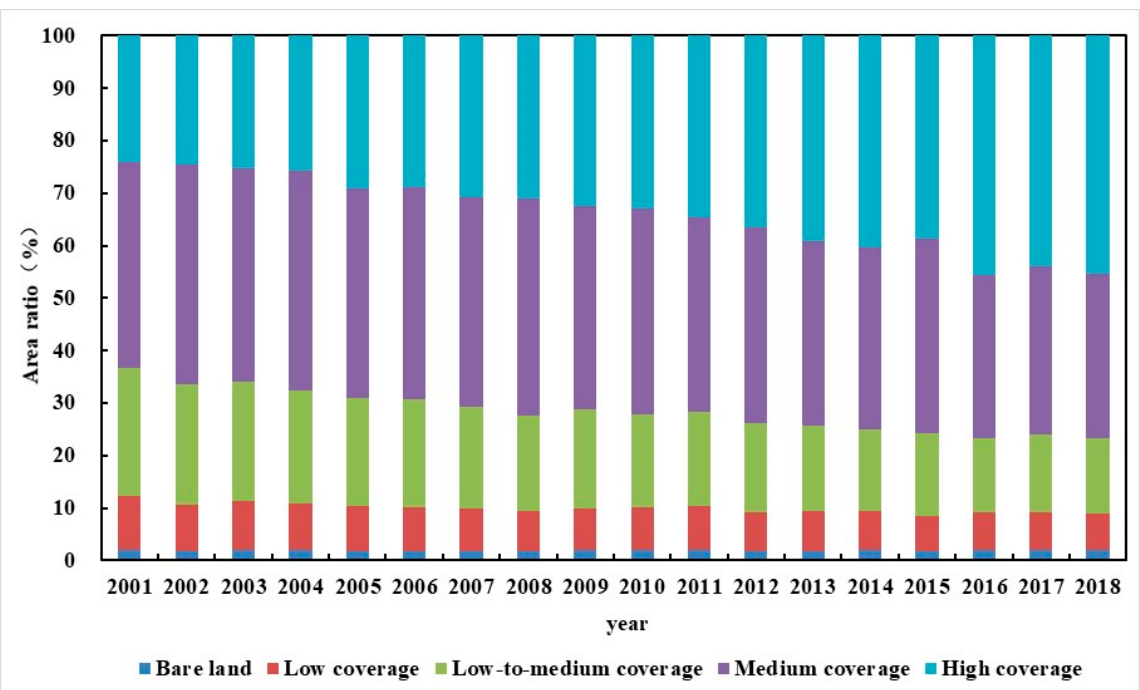
Figure 3. The variation trends of various FVC classes in the subtropical region from 2001 to 2018.